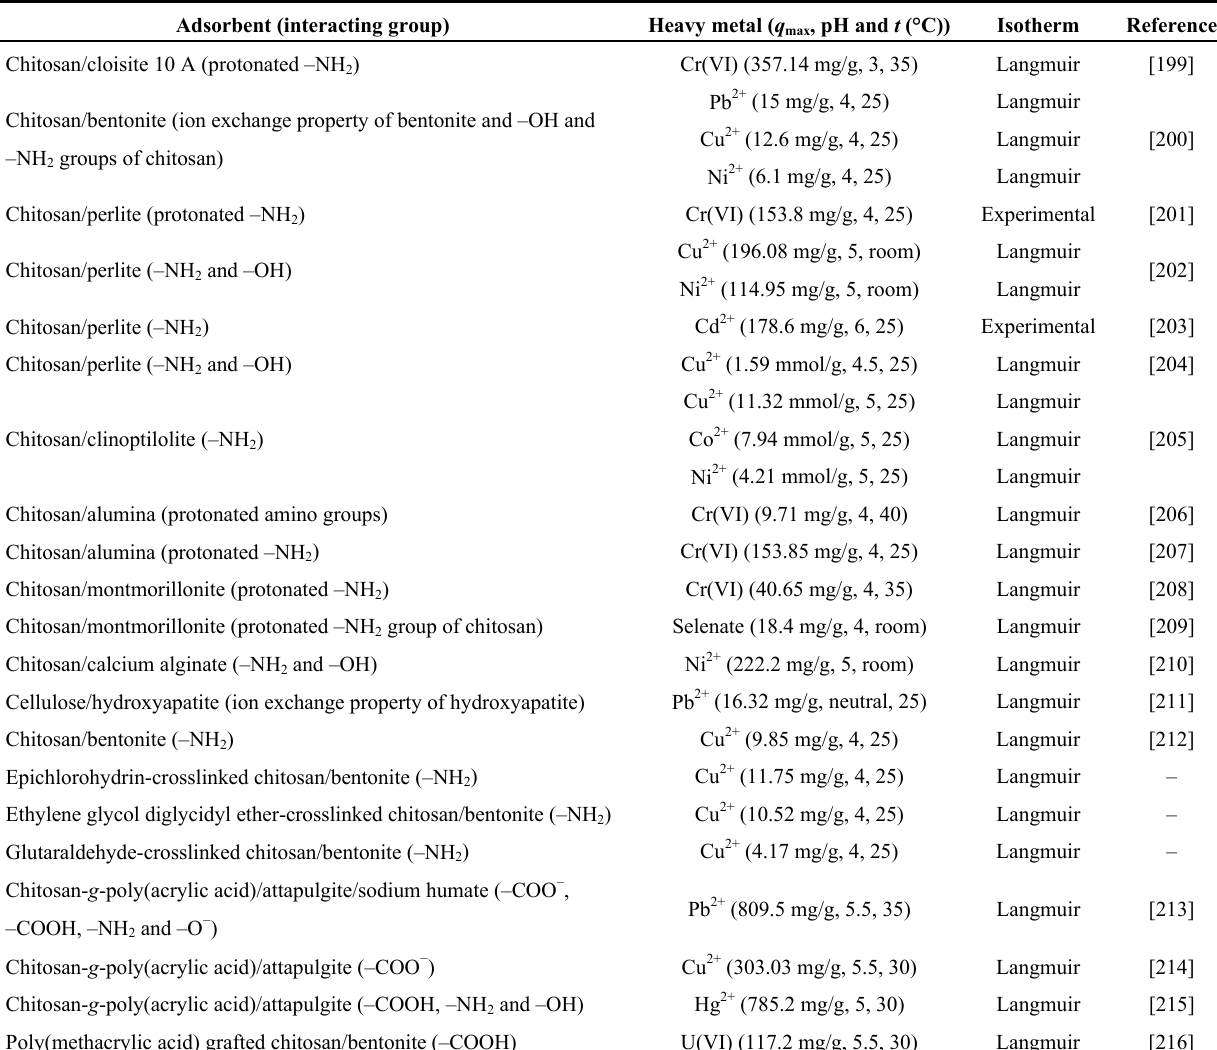
Table 3. Adsorbed heavy metals, maximum adsorption capacity, pH and temperature for adsorption of heavy metals by organic polymer/layered compound